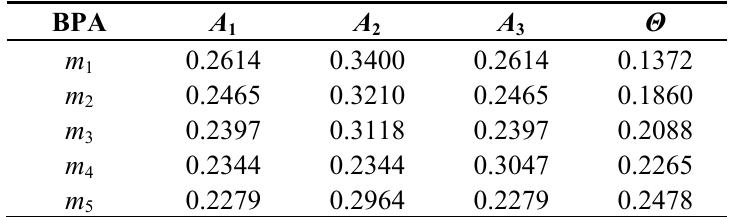
Table 2. Initial recognition result by SVM multiple